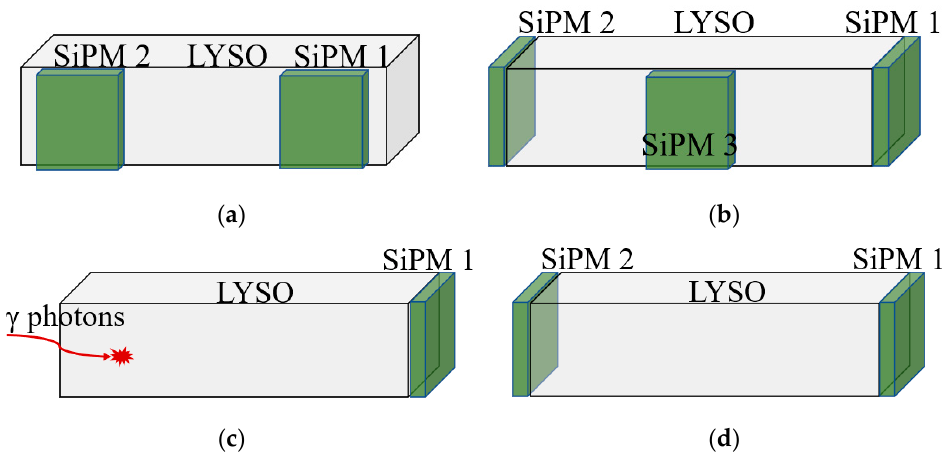
Table 1. Parameters in simulation.